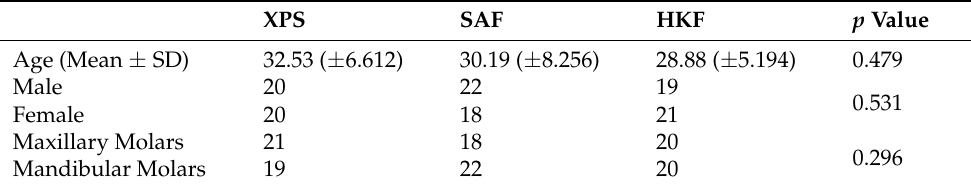
Table 1. Demographic details and teeth